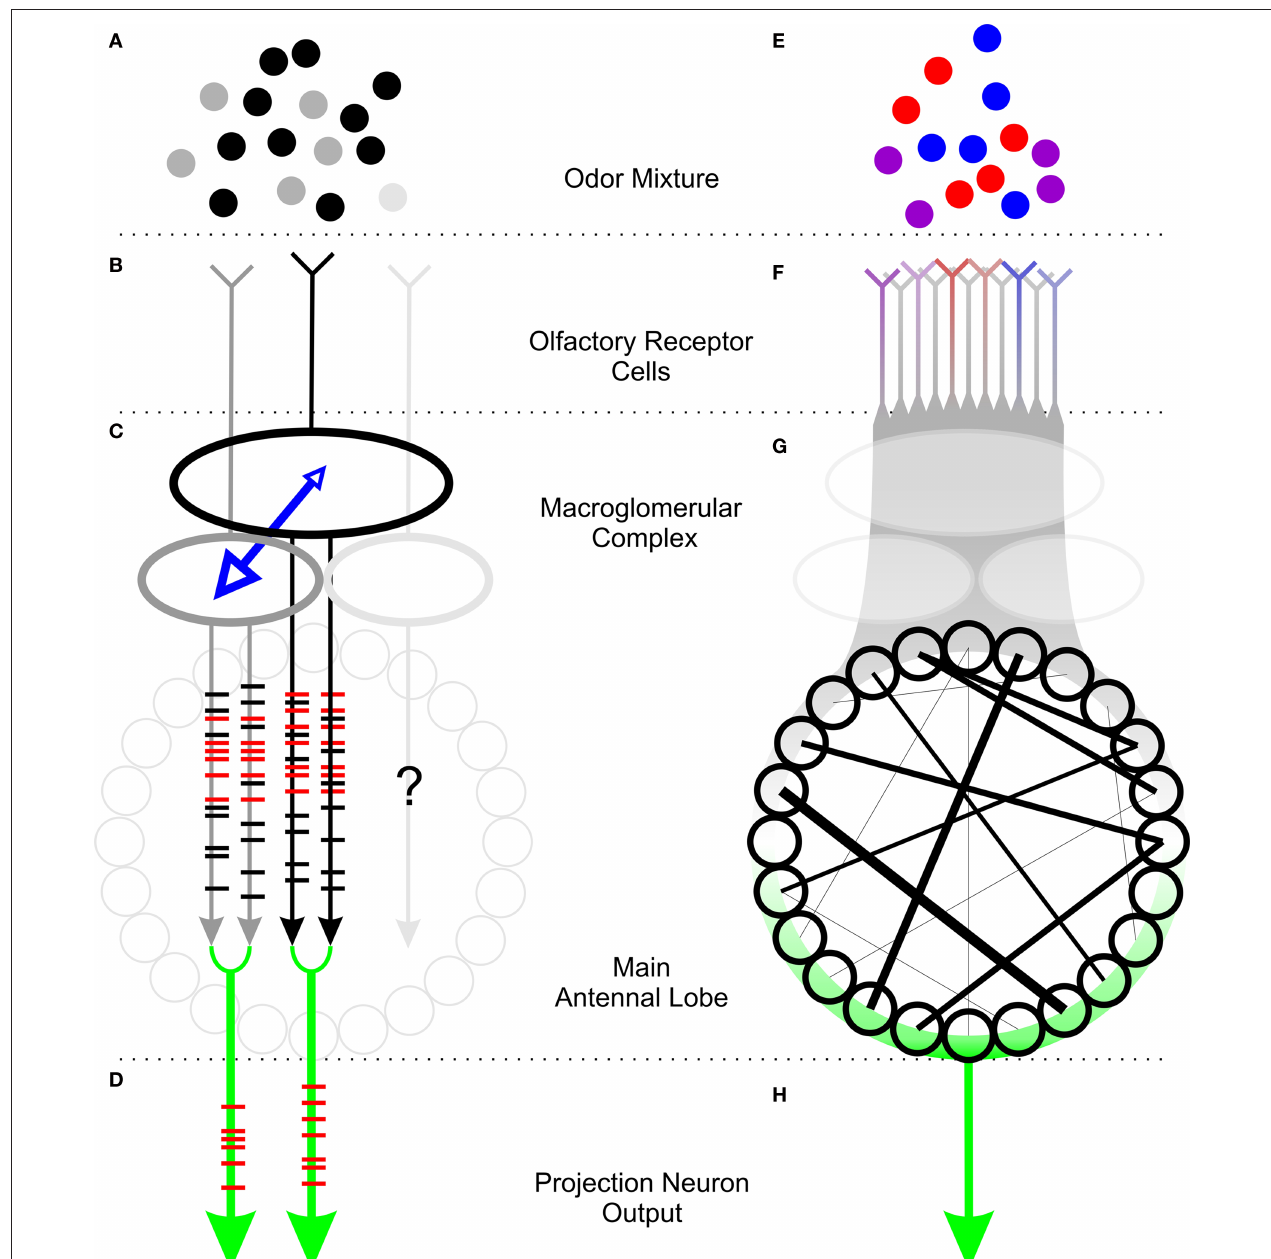
pheromone includes a high proportion of synchronized spikes (red rasters). (D) Trains of synchronous spikes comprise the mixture-specific output of the MGC. (e) Plant odors typically include a large number of volatiles (colored circles), of which only a few may be necessary to elicit behavior. (F) Multiple ORCs respond to plant volatiles to varying degrees (colors represent specificity to correspondingly colored component from E, saturation of color represents sensitivity). (g) Stimulation with an innately attractive odor produces a pattern of synchrony (black lines) across the AL. (H) The mixture-specific output of the main AL is characterized by a pattern of synchronized firing of PNs from across the